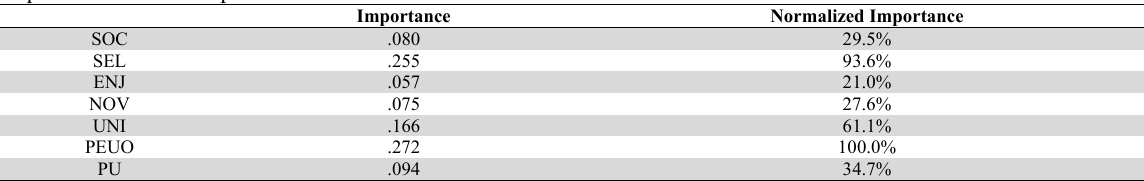
Independent Variable Importance